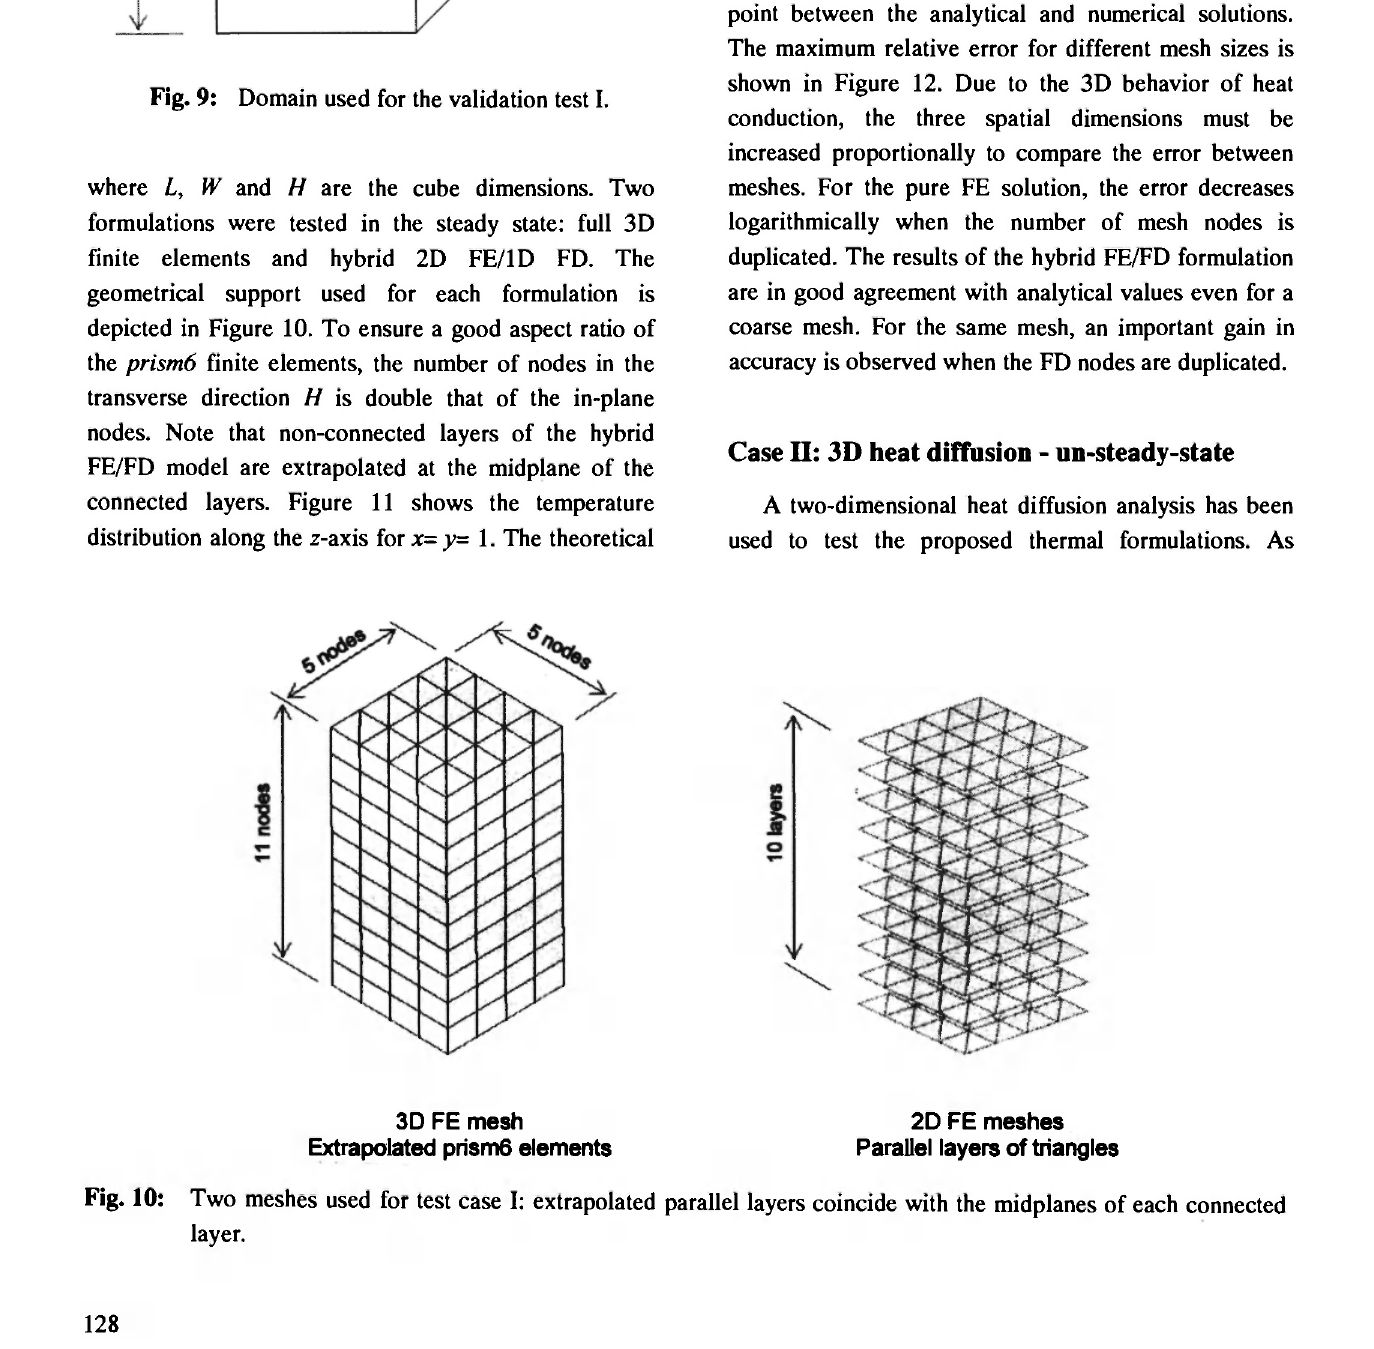
Fig. 9: Domain used for the validation test I.